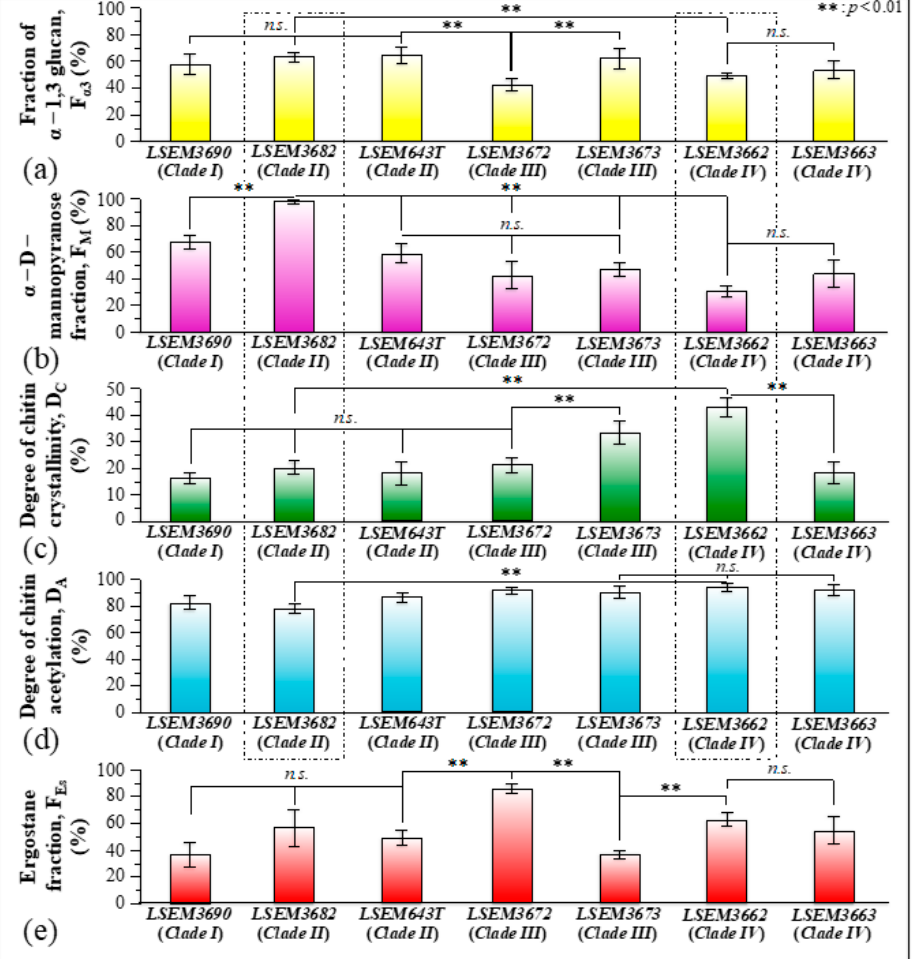
Figure 10. Metabolite fractional parameters ( a – e ): F α 3 , F M , D C , D A , and F Es (cf. labels), as determined from Raman experiments on the investigated C. auris samples. Standard deviations are indicated in inset together with statistical evaluations performed on Raman maps collected at different locations ( n = 3; with significance p < 0.01 labeled with